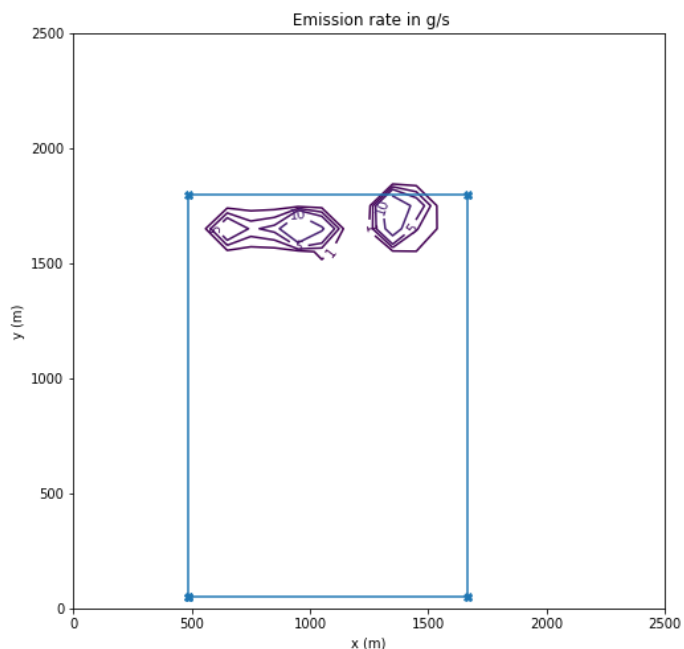
Figure 5. Inferred distribution of landfill emissions of methane for 5 June 2021, 7:10 a.m. to 7:27 a.m., based on MPAL measurements. Contours are drawn for 1, 3, 5, and 10 g/s. Blue line is approximate border of the landfill.